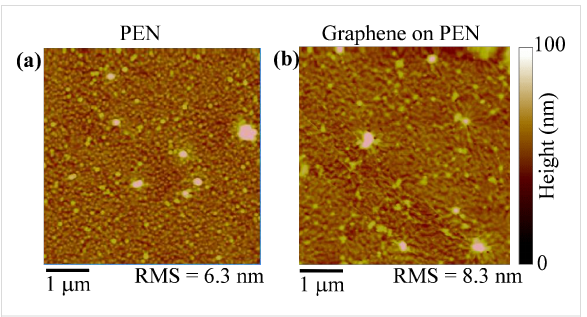
Figure 3: Tapping-mode AFM images of the bare PEN surface (a) and of graphene transferred onto PEN